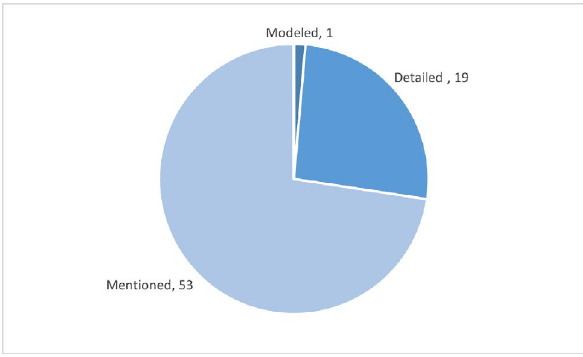
Figure 1. Levels